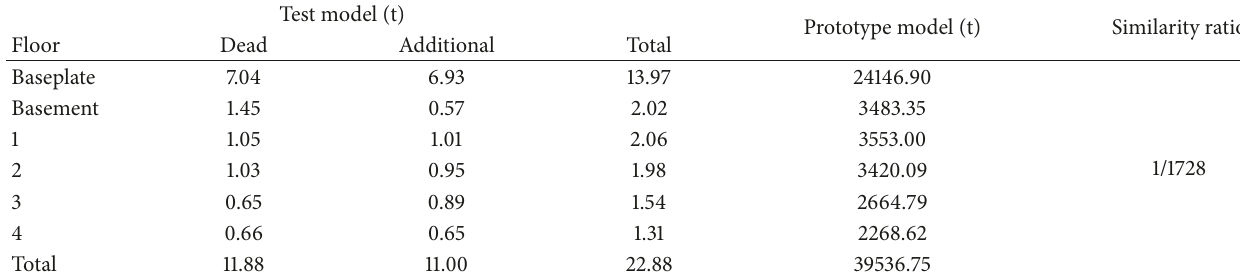
Table 3: Weight of each layer.